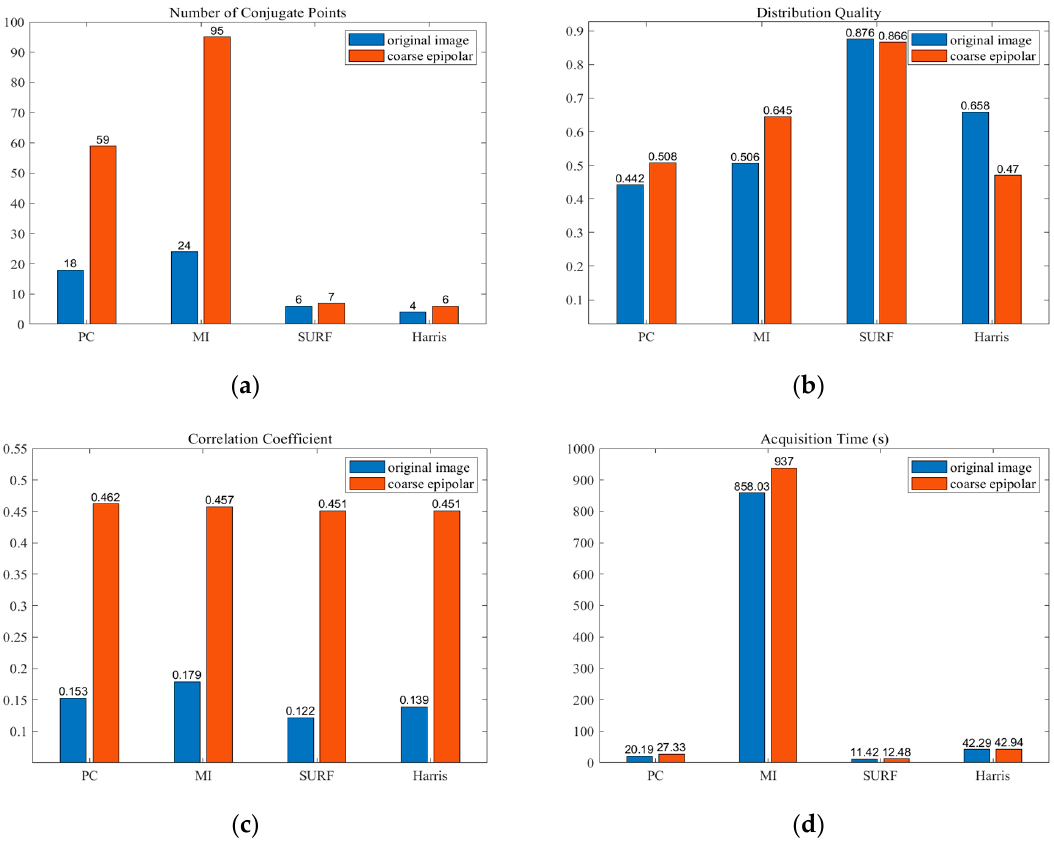
Figure 12. Matching results of Kompsat-3A across-track stereo images (template size: 500 × 500 pixels): ( a ) number of extracted conjugate points, ( b ) distribution quality, ( c ) correlation coefficient, and ( d ) acquisition time.